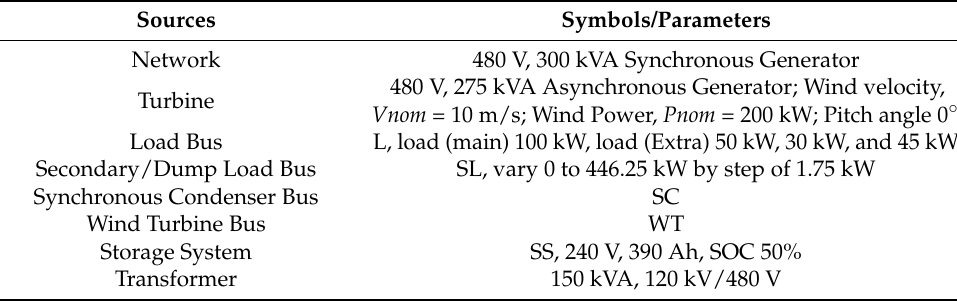
Table 1. Parameters for tested WDHPS network.